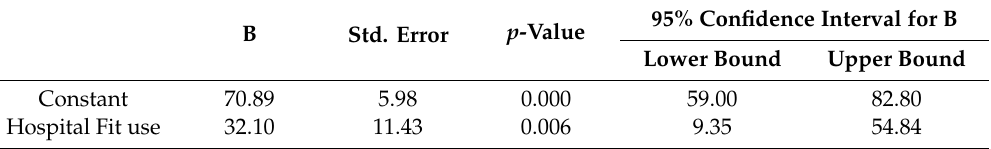
Table 2. Univariate linear regression analysis—the association between the time spent physically active on postoperative day one (POD1) and Hospital Fit